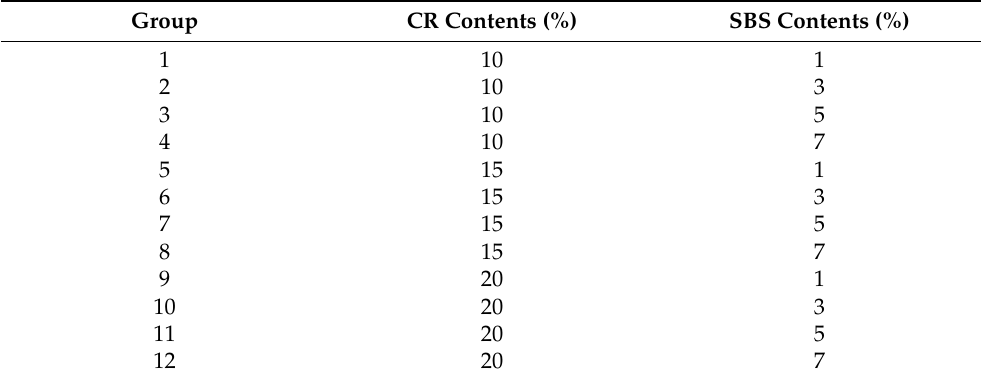
Table 3. The mix proportions for the CR- and SBS-compound-modified